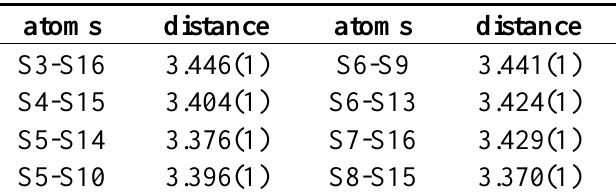
Table 10. Intermolecular S···S distances (in Å) shorter than the sum of the van der Waals radii (3.60 Å) in compound 5